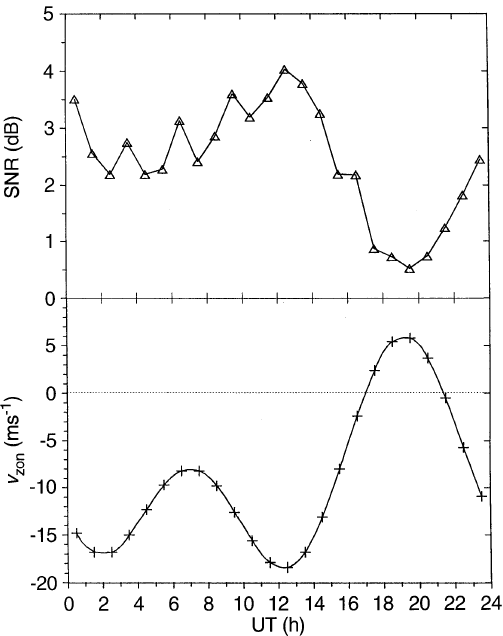
Fig. 11. Comparison of the mean diurnal variation of SNR obtained by ALOMAR SOUSY measurements with the zonal wind deduced from MF-radar observations at